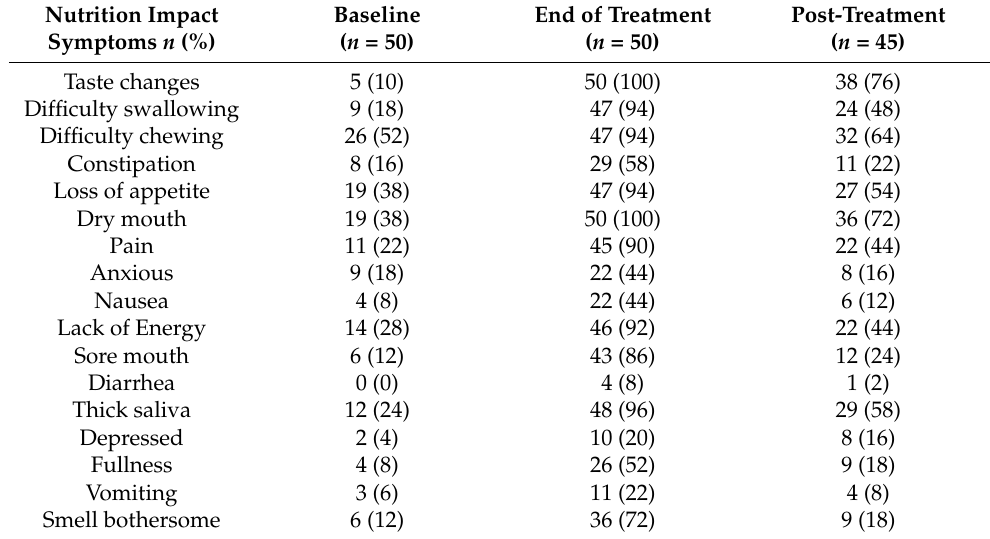
Table 4. NIS experiences in HNC.